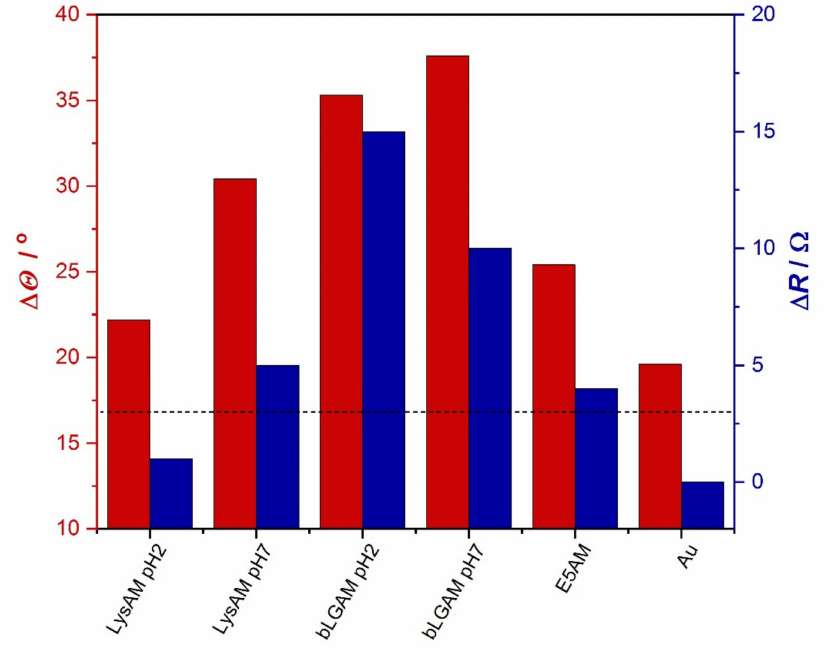
Figure 9. Water contact angle hysteresis ( ∆Θ , red) on QCM crystal (Au) and with adsorbed protein layers on it as well as the motional resistance ( ∆ R , blue) of the corresponding crystal in QCM measurement. ∆ R = 3 Ω value is indicated in dashed